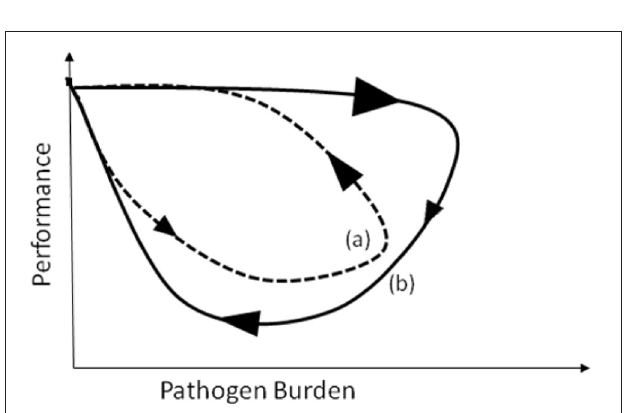
FIGURE 2 | Schematic figure representing pathogen burden–performance trajectories for two individuals (a) and (b) with different resistance and tolerance mechanisms. The direction and size of the arrows indicate the direction and velocity at which trajectories evolve over